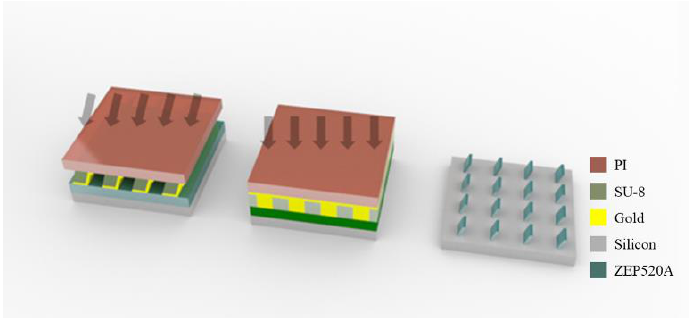
Figure 7. Fabrication of multi-scale structures with a dotted–dashed line shape. Oblique exposure for sub-micron structure was followed by vertical exposure for micron structure. Final structure was periodic sub-micron oblique structure.